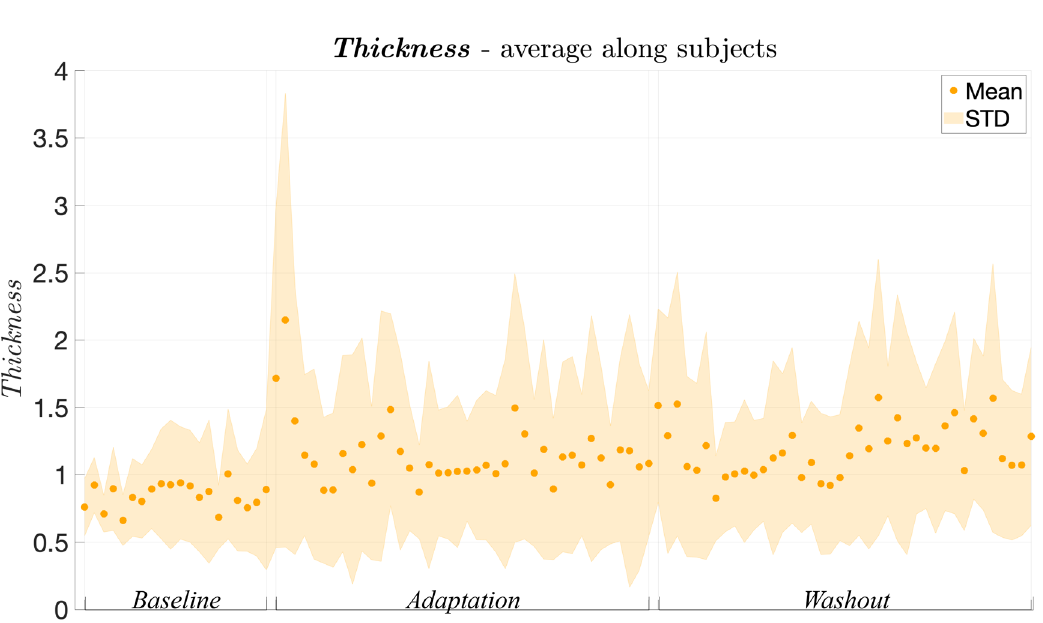
Figure 5. Thickness averaged along participants over